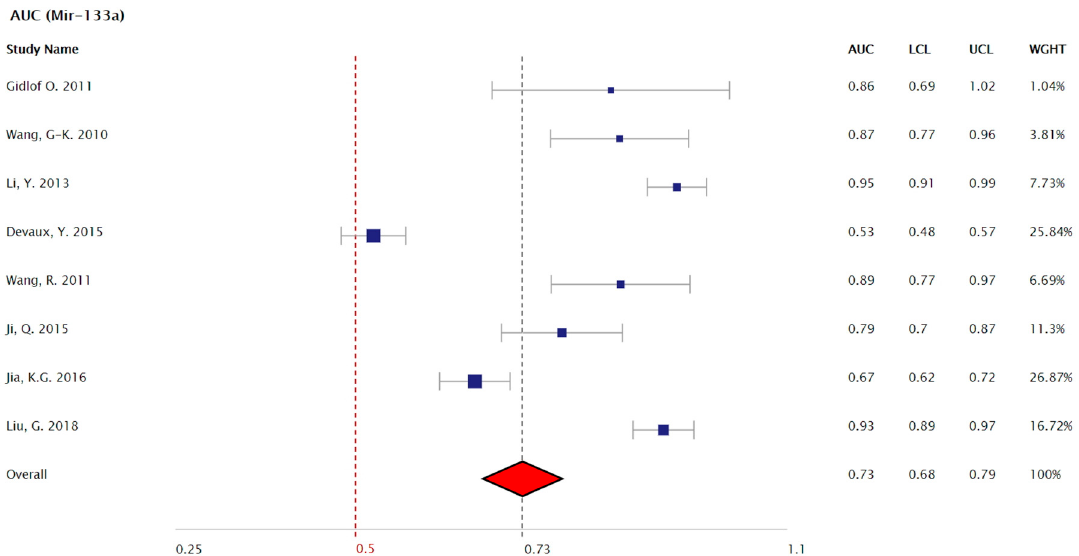
Figure 2. Forest plot of Mir-133a AUC values for the detection of AMI for each of the included studies. Pooled AUC value of 0.73 (95% CI 0.68–0.79). It is important to note that 5 out of 8 studies yielded AUC values greater than 0.86, yet, their overall weight was reduced by the relatively low number of included subjects.